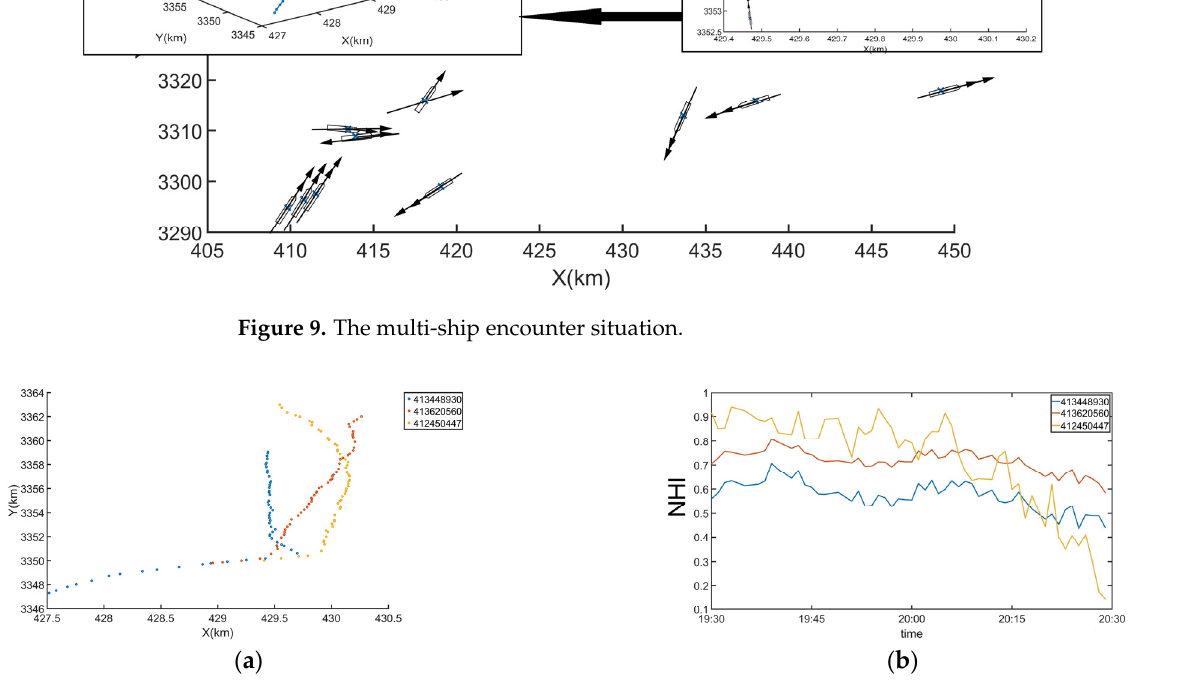
Figure 11. Position of three ships: ( a ) the three ships at 19:30; ( b ) the three ships at 19:40; ( c ) the three ships at 19:51; ( d ) the three ships at 20:00; ( e ) the three ships at 20:29.